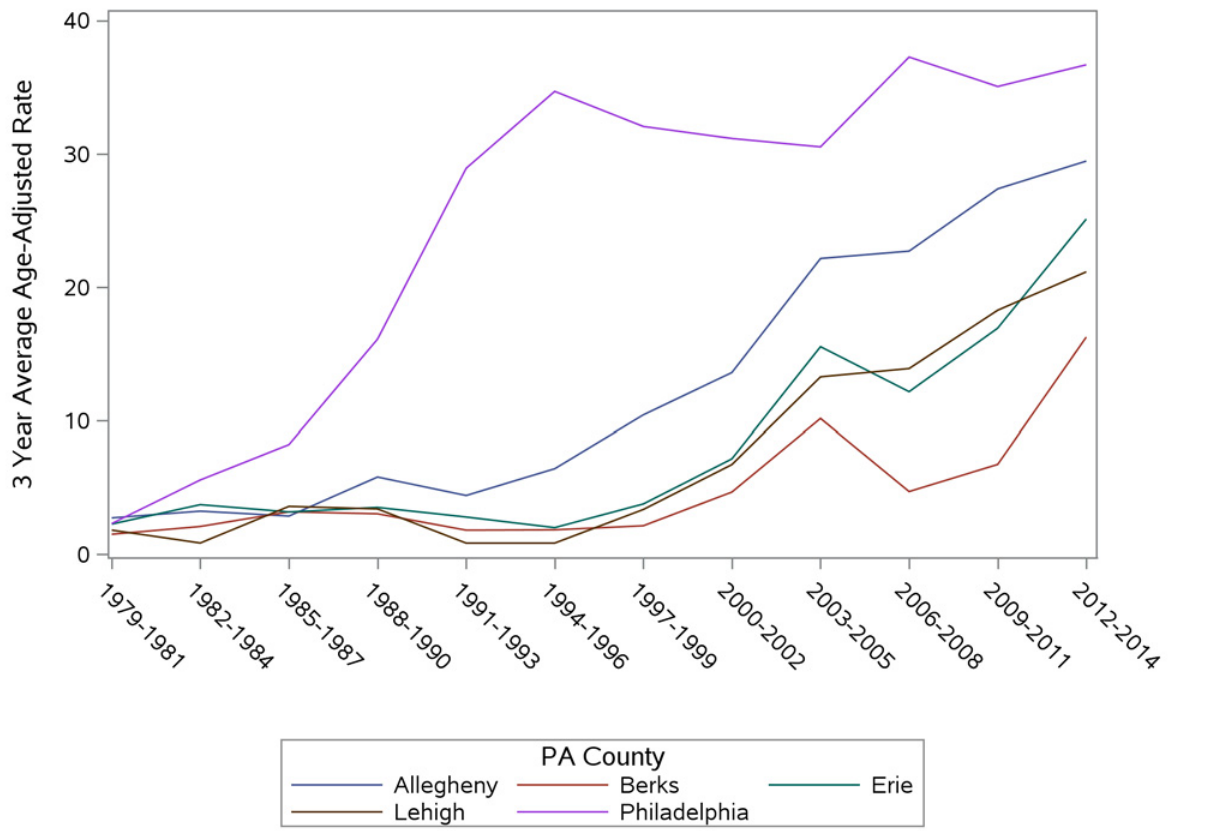
Fig 4. Three Year Average Age-Adjusted Poisoning Mortality Rates for Counties with the Top 5 Largest PA Cities, 1979 – 2014.